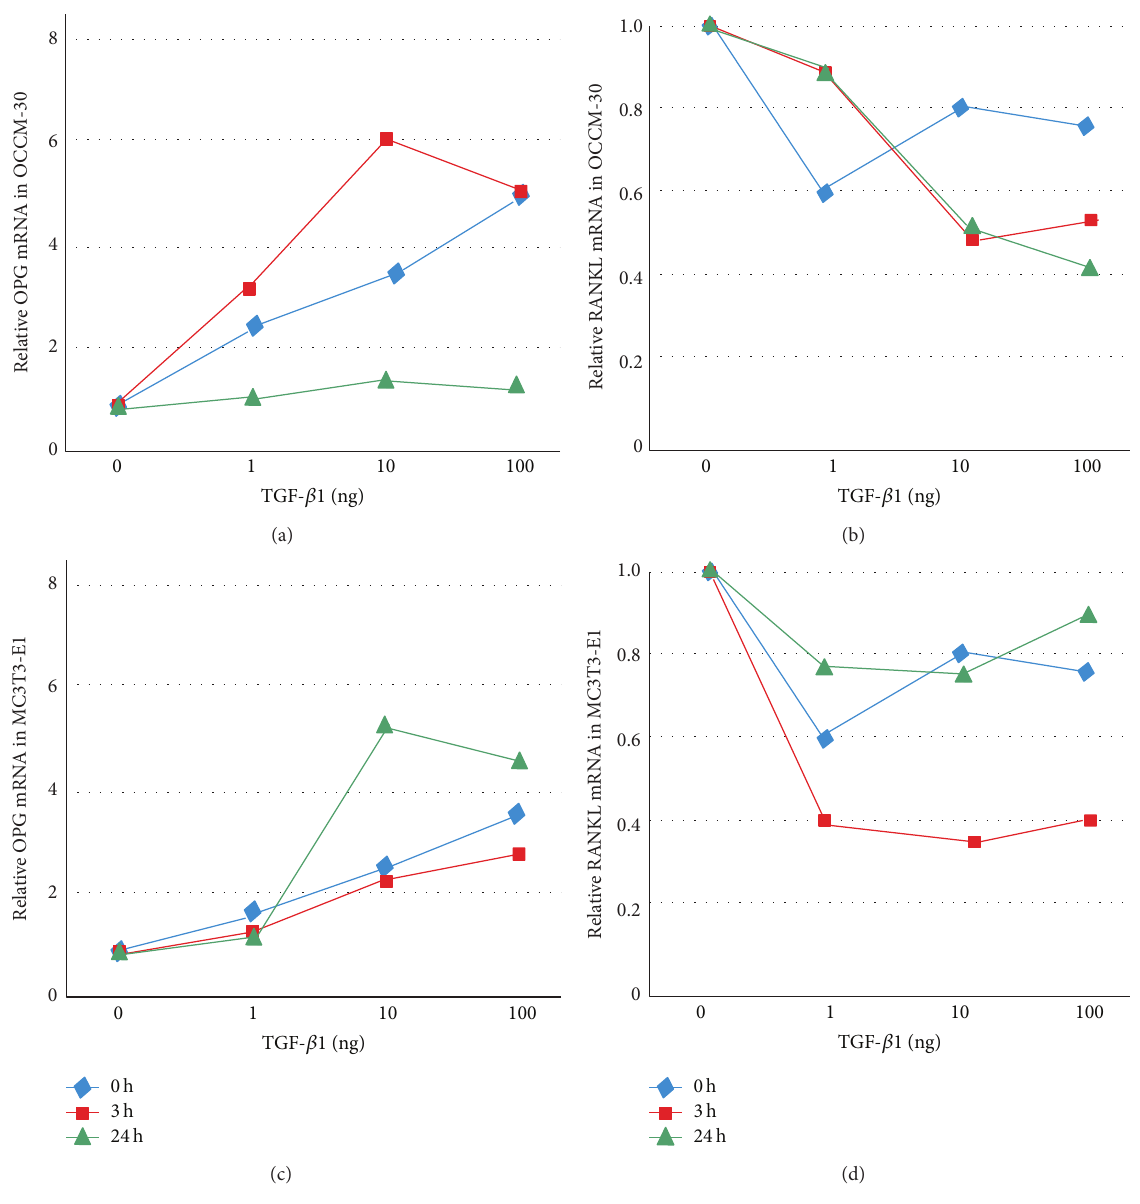
and osteoblasts under mechanical compressive stress. The expression change trends of OPG/RANKL are similar under 3 h compressive stress but higher in cementoblasts, and the change point and amount are different with TGF- 𝛽 1 concen- tration change between cementoblasts and osteoblasts. Under 24 h mechanical compressive stress, TGF- 𝛽 1 also affects the expression of OPG and RANKL in cementoblasts and osteoblasts differently, and the OPG/RANKL ratio change is higher in